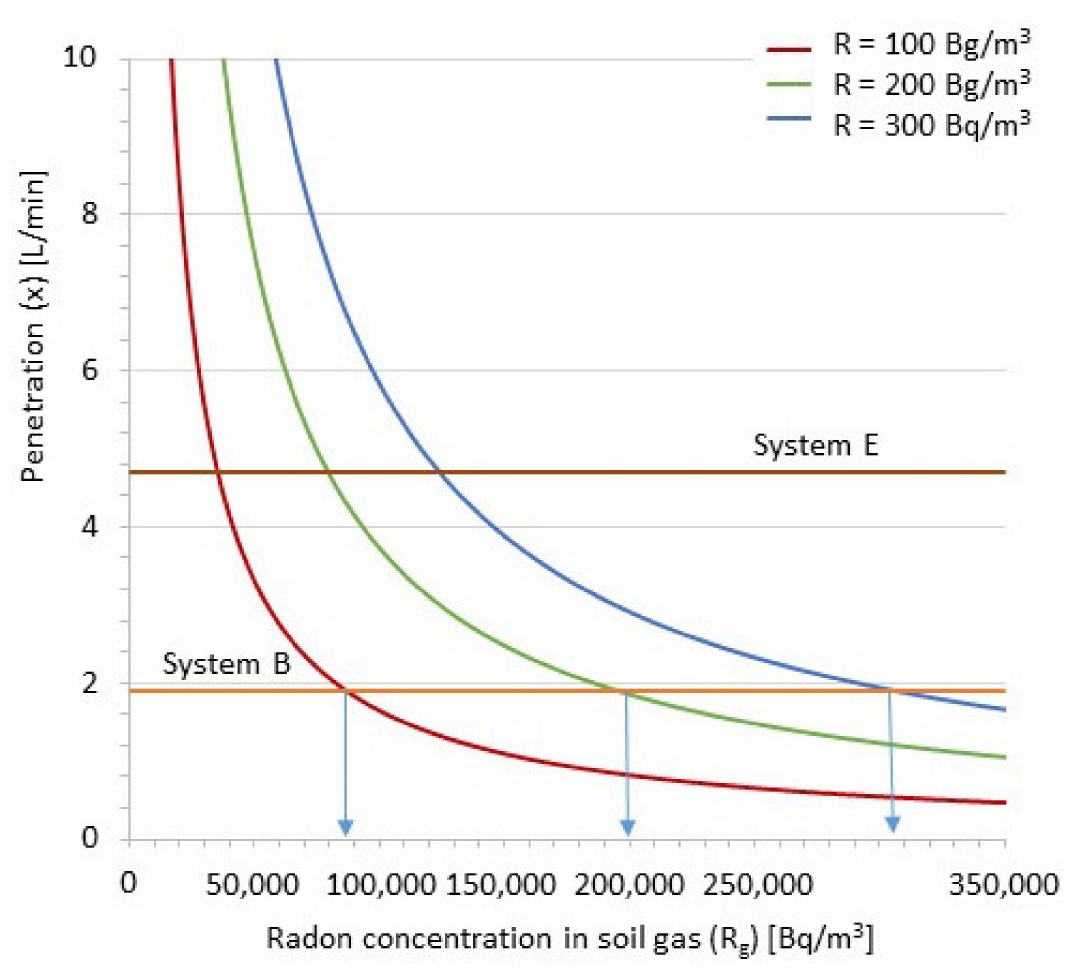
Figure 9. Radon barriers for System B and E, where the intersection between the horizontal line indicating the measured airtightness and the curves for reaching an acceptable radon indoor-air level of 100, 200 and 300 Bq/m 3 provides the critical radon concentration in soil